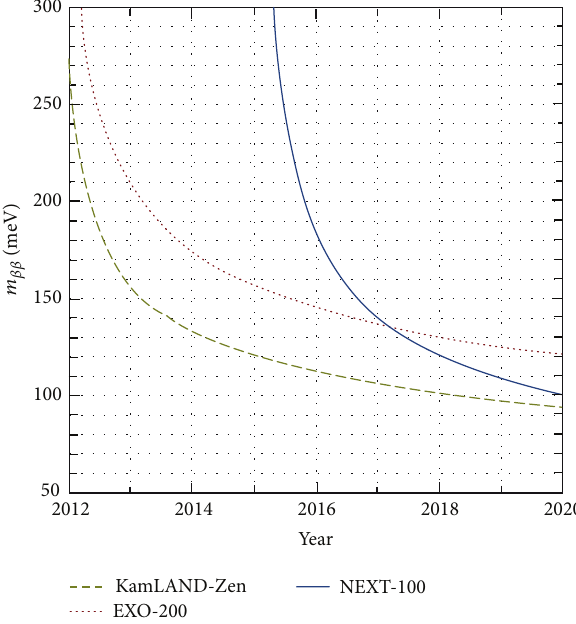
Figure 4: The cosmological constraint on the sum of the neutrino mass derived from Planck combined with other data, together with the best limits from 𝛽𝛽0 ] experiments (KamLAND-Zen + EXO) and the expected limit that can be reached by the high-performing experimentsinthetonscale,inparticularNEXT. |𝑚 𝑒𝑒 | istheeffective Majorana massdefined in (2), and IHand NH stand for inverted and normal hierarchy, respectively. Adapted from [4].